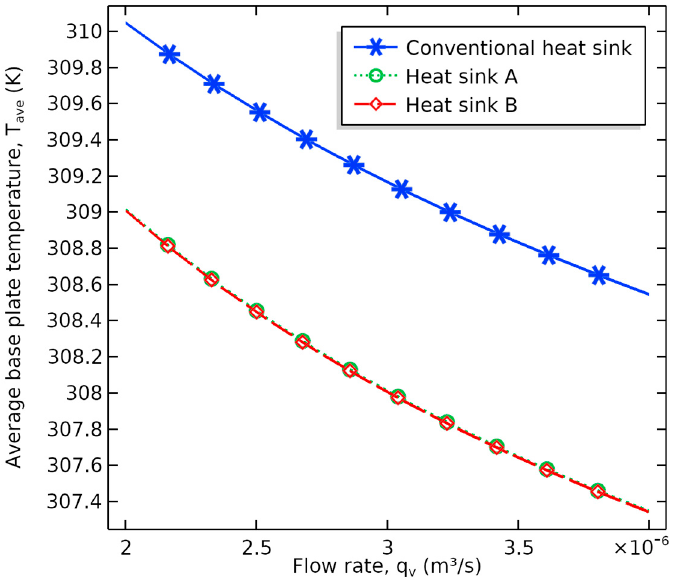
Figure 9. Average temperature at the base plate of the heat sink versus volumetric flow rate.